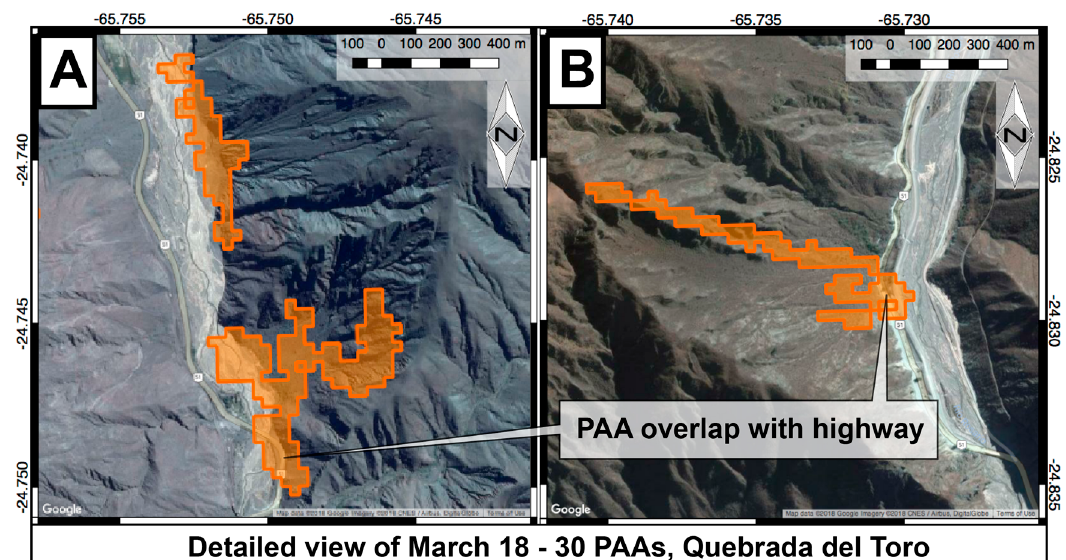
Figure 7. Details of PAA overlap with highway infrastructure. Satellite optical images from this time are obscured by cloud cover, but detected PAAs are located downslope of scree slopes and gullying ( A ) and high-relief surfaces ( B ) with potential for landslides or mudflows. Satellite imagery from Google Earth Pro, CNES/Airbus, and Digital Globe.